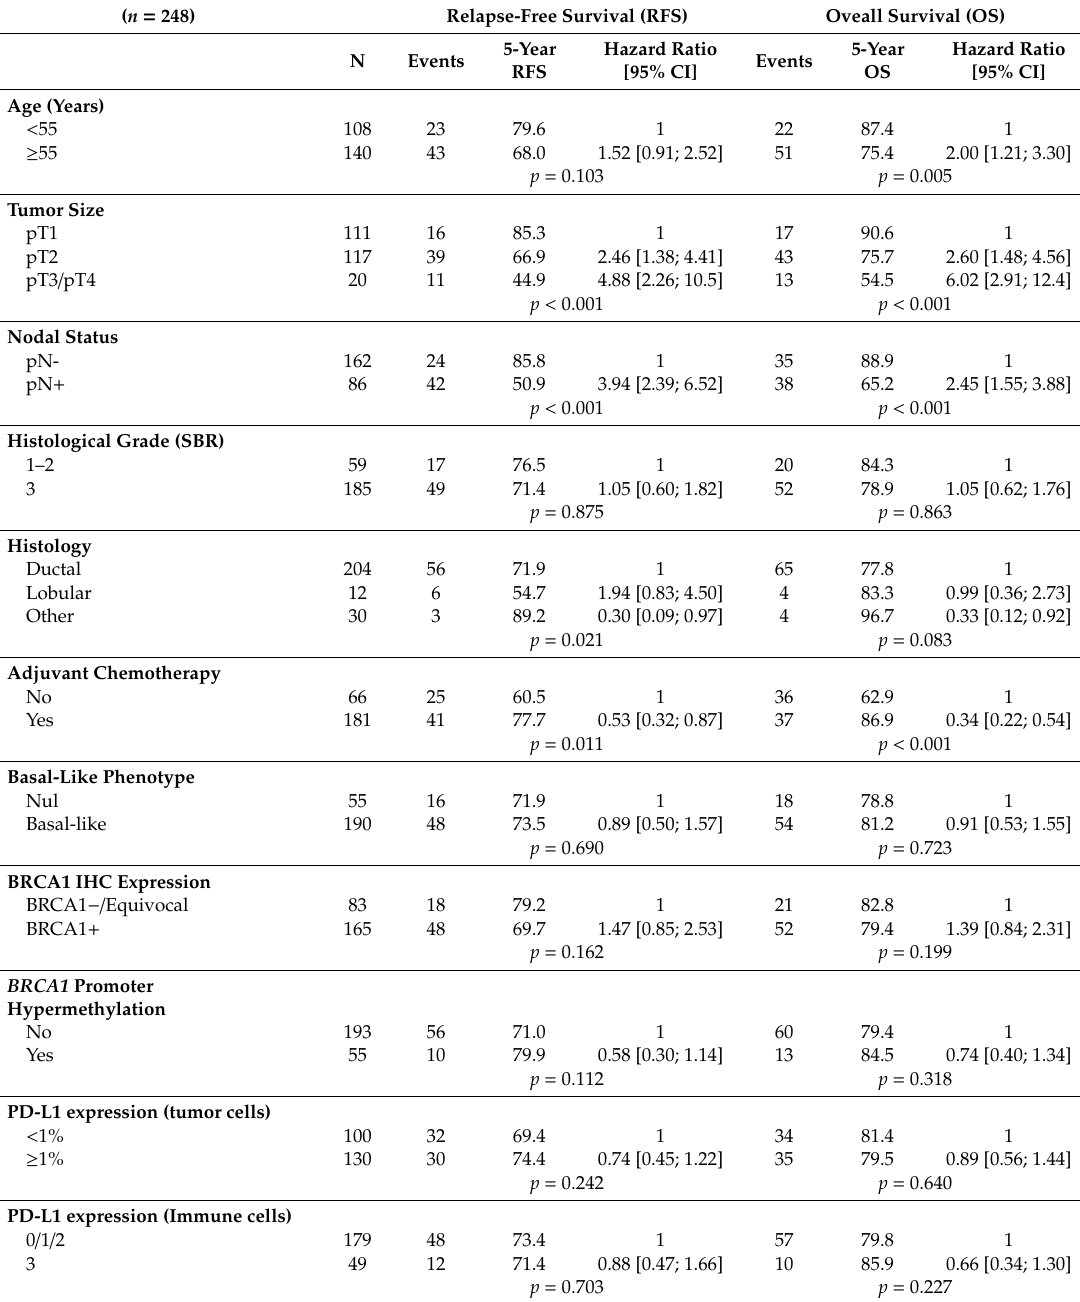
Table 3. Univariate